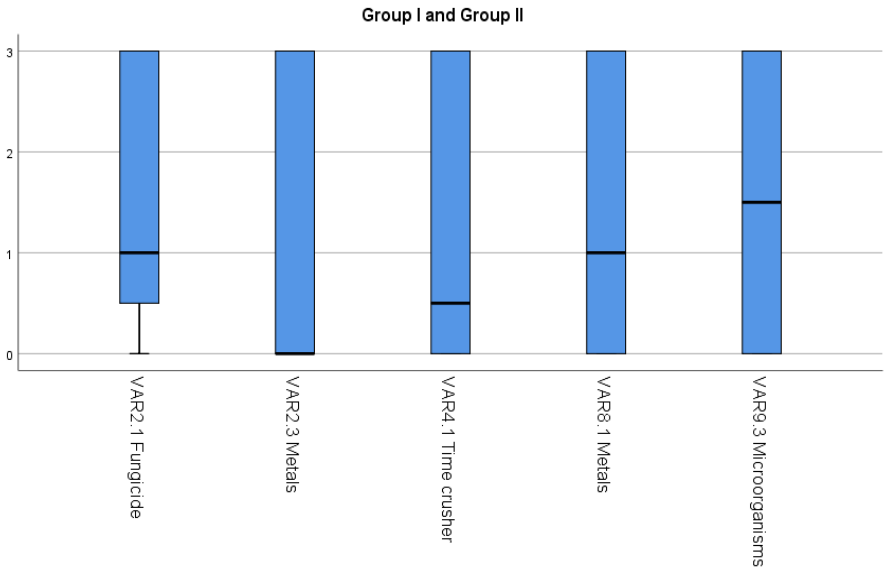
Figure 2. Median and range interquartile for variables included in Group I and Group II.